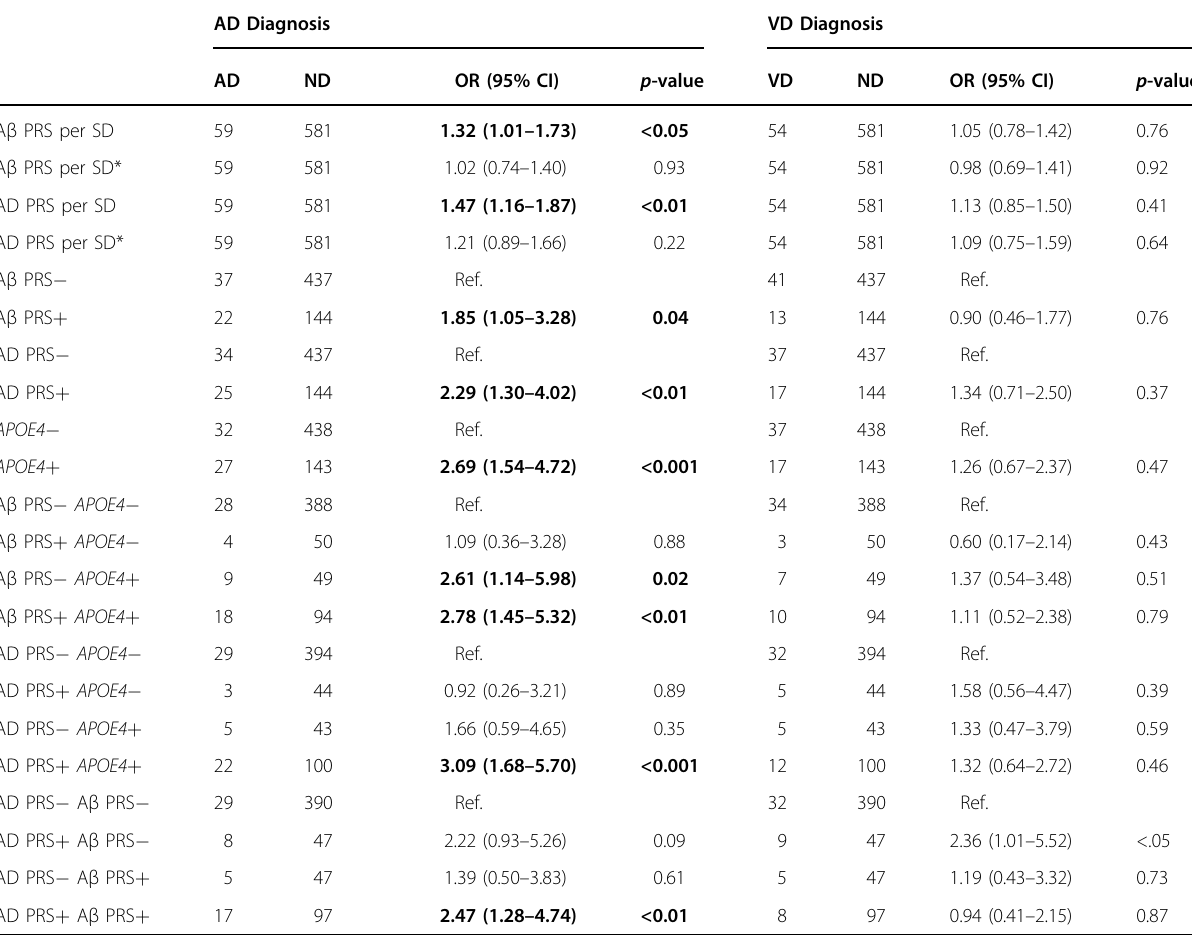
Table 3 Logistic regression results: prediction of AD and VD diagnoses by Alzheimer ’ s and A β polygenic risk. AD